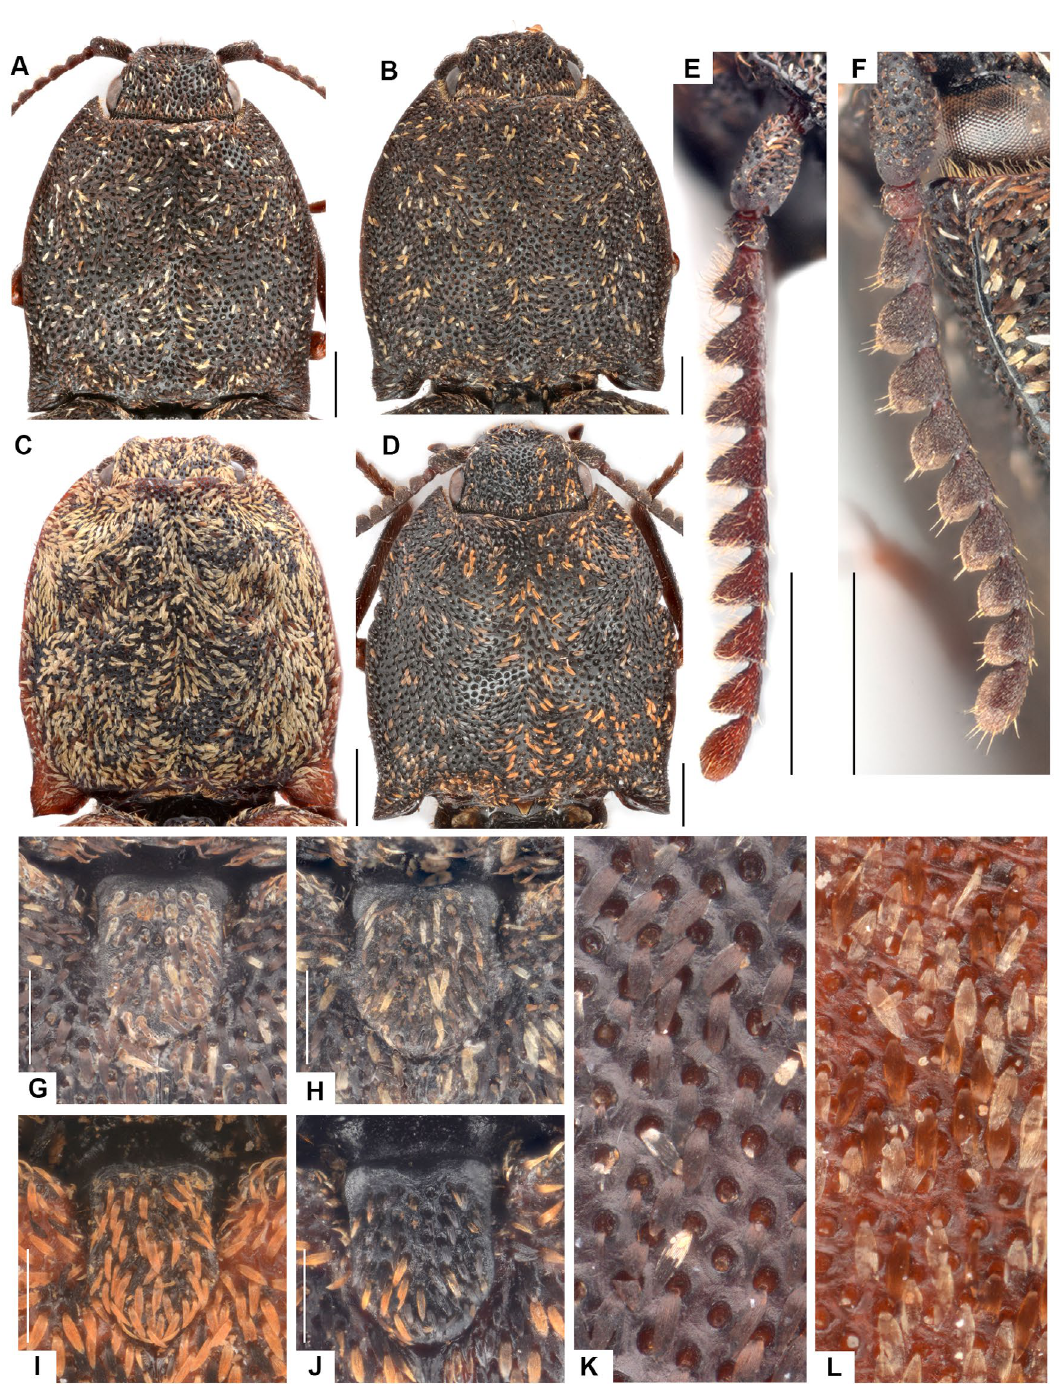
Fig. 2. Details of pronotum, antenna, scutellar shield and elytral surface of Lacon spp. A–D . Pronotum, dorsal view. A . L. mertliki sp. nov., holotype, ♂. B . L. mertliki sp. nov., paratype, ♀. C . L. lepidopterus (Panzer, 1801), ♂ (lectotype of L. aurosquamosus (Jagemann, 1944)). D . L. lepidopterus , ♂ from Turkey. E–F . Antenna of L. mertliki sp. nov. E . Holotype, ♂. F . Paratype, ♀. G–J . Scutellar shield. G . L.